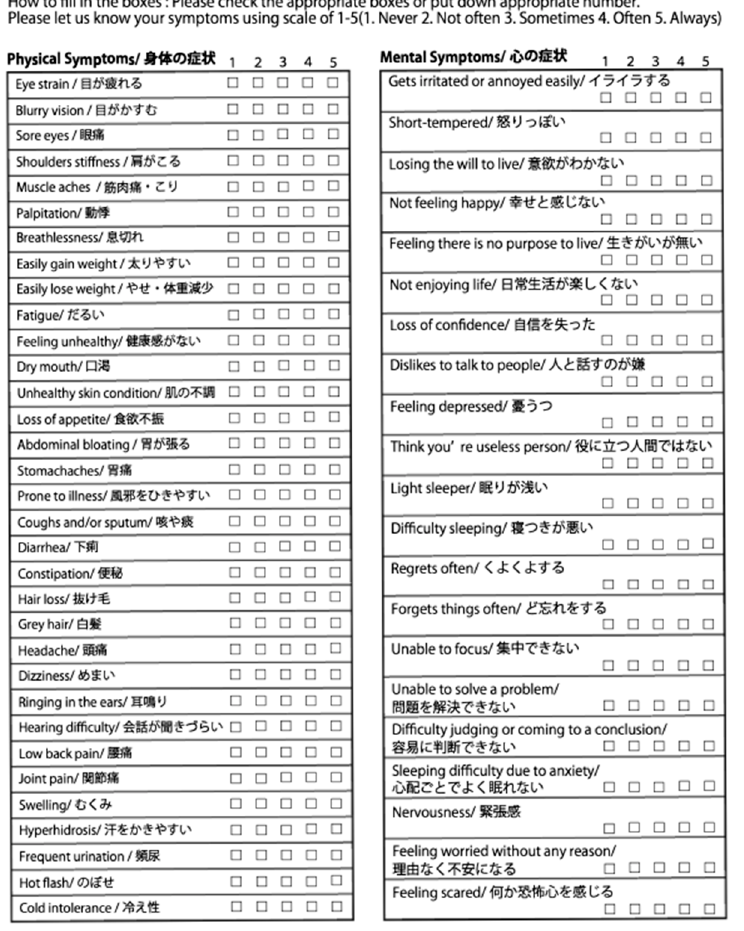
Figure 1. Anti-aging QOL Common Questionnaire. The questionnaire is composed of 33 questions relating to physical symptoms and 21 questions relating to mental and emotional symptoms.